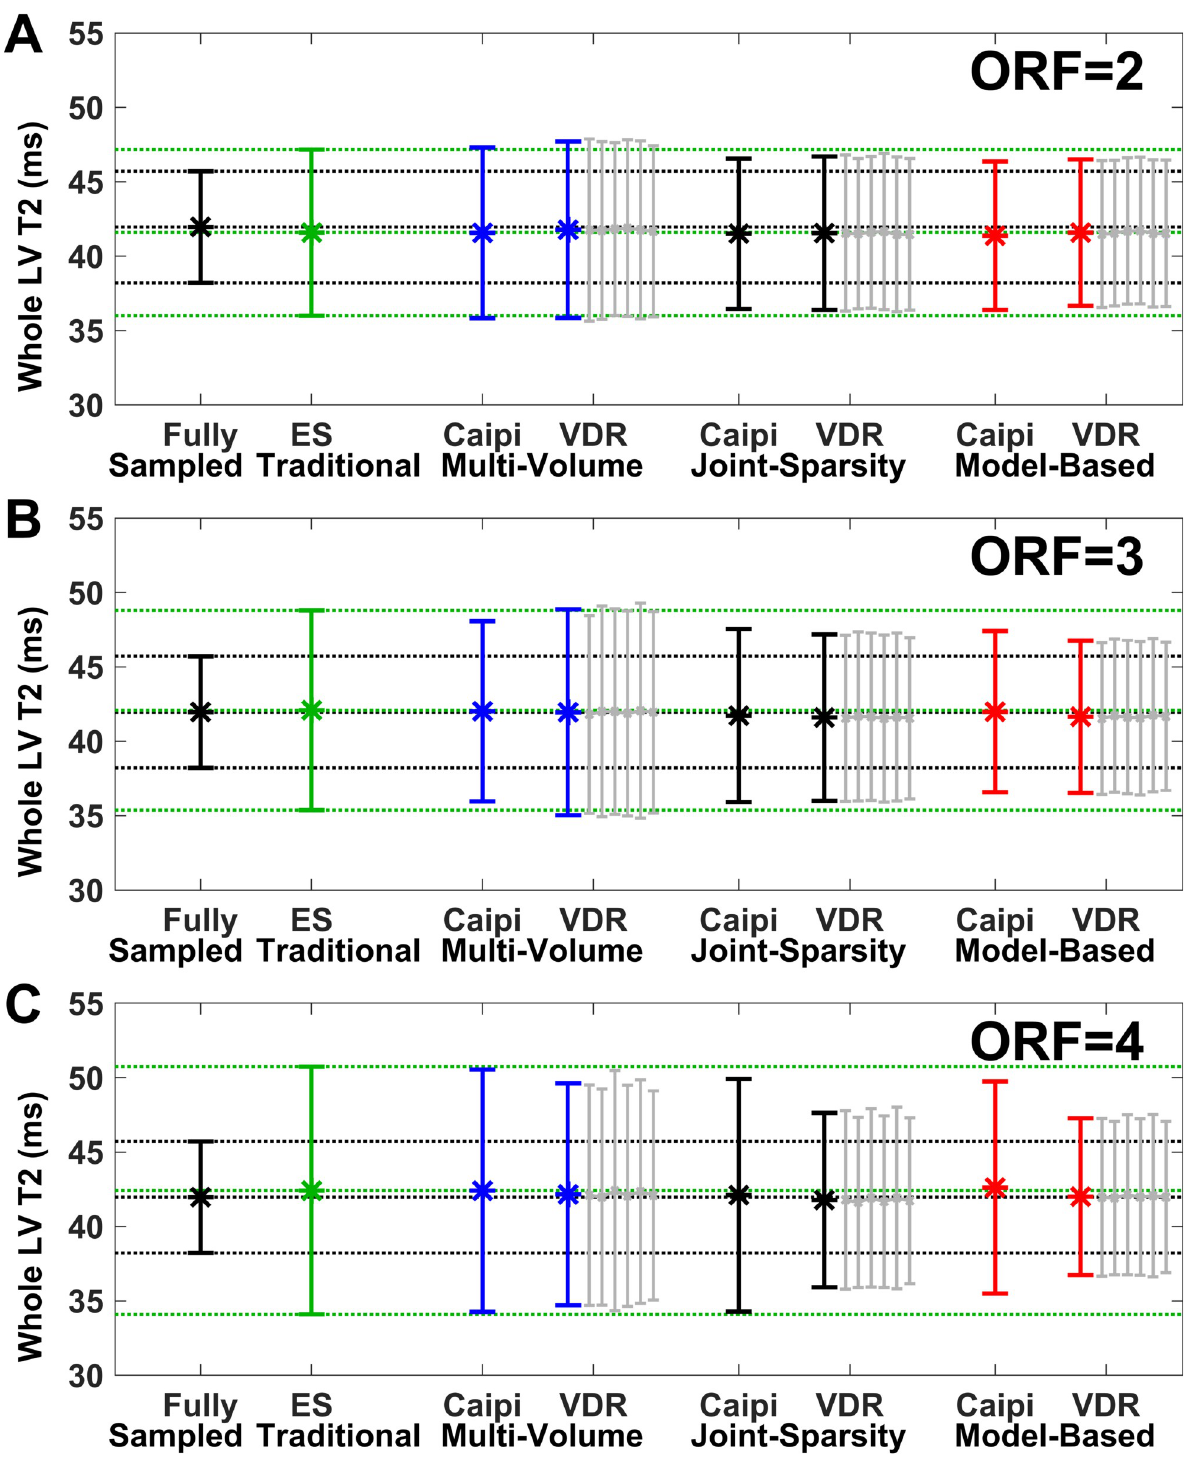
Fig 4. Comparison of the effects of sampling patterns and reconstruction approaches on whole-heart LV T2 mean and SD (error bars) for ORF = 2–4. The swine is the same as shown in Fig 3. Reconstruction of fully sampled data (black) is used as the reference, with mean and standard deviation extended throughout the plots (black dotted lines). Traditional SENSE (green), represents a secondary reference with independent volume- by-volume processing which demonstrates the results of acceleration as readily available online on scanners, with mean and SD extended throughout the plots (green dotted lines). Variable density random (VDR) sampling was repeated six times (gray lines) for each method and results were averaged. Deviation from the mean T2 of the fully sampled reference represents bias and SD represents precision.